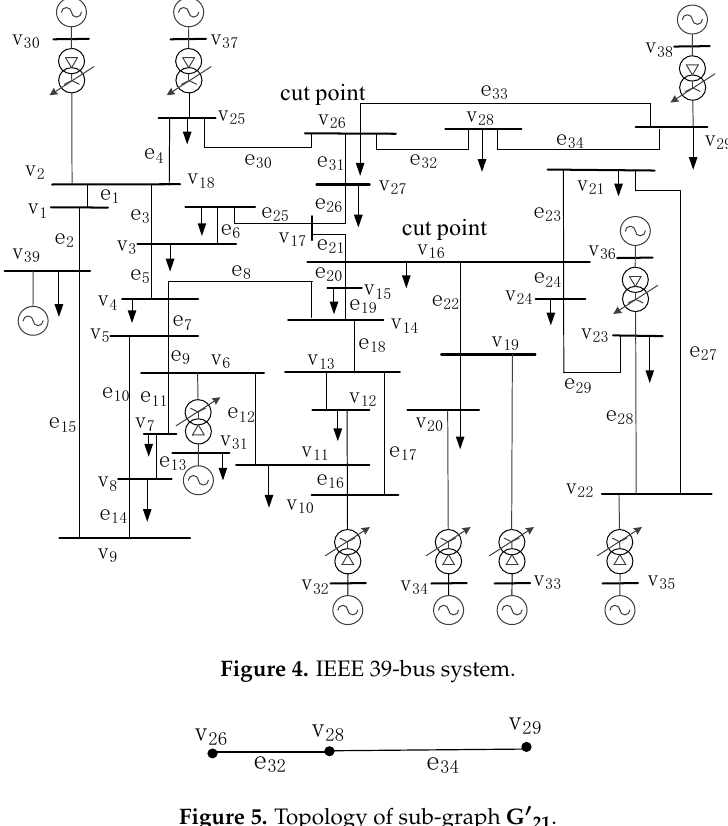
Figure 5. Topology of sub-graph G’ 21.